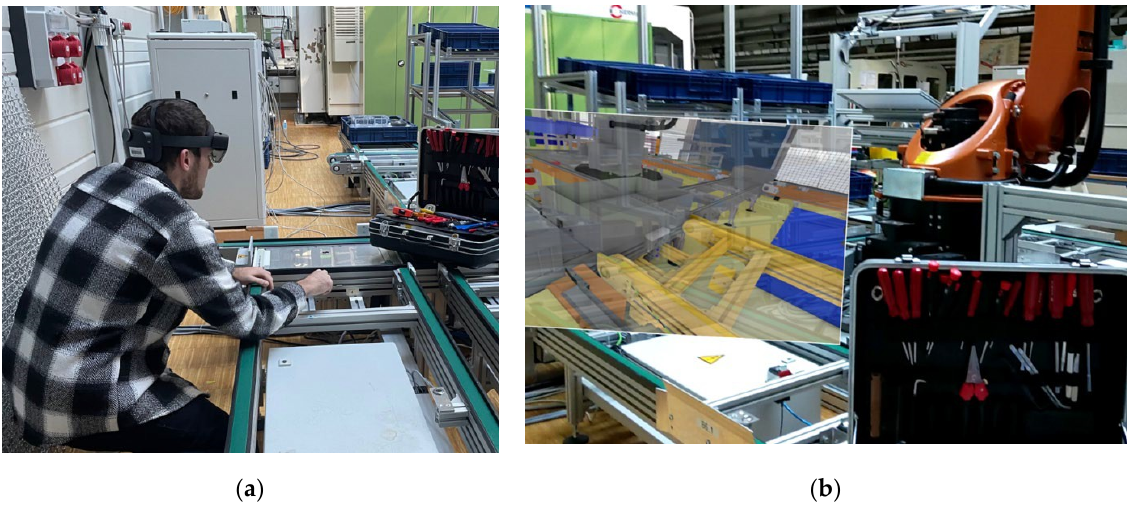
Figure 3. ( a ) Field technician with AR headset. ( b ) The Field of view in the AR headset. If the field of view of the VR headset is not ideal, it is also possible to switch to a